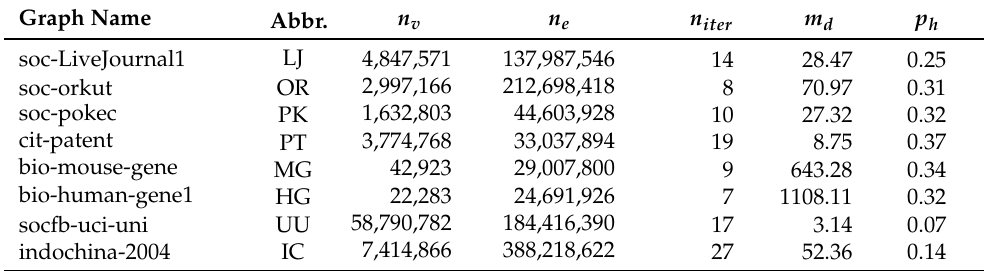
Table 2. Graph specifications. n iter is the average of the number of iterations to finish